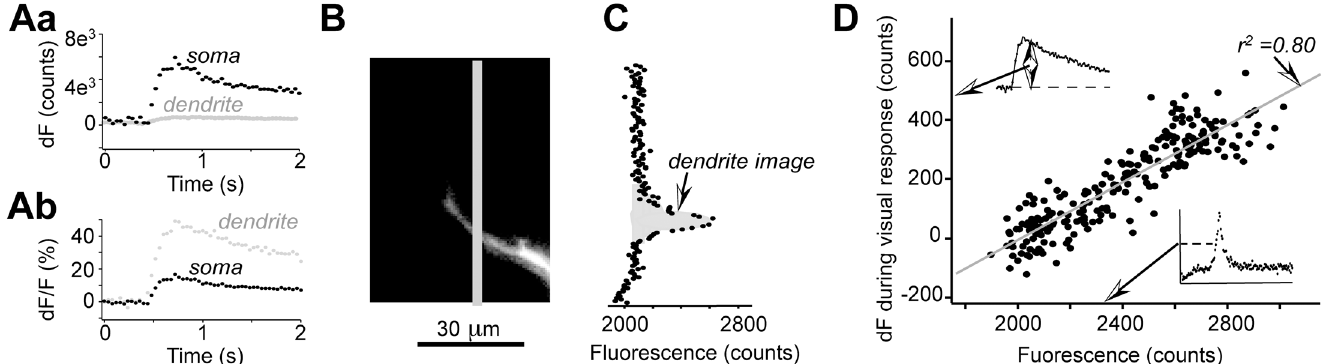
Fig 2. The recorded calcium transients could be detected only on the dendritic branches of the patch-clamped neuron. A . Calcium indicator OGB-1 fluorescence signals in response to several action potentials are shown for soma (black dots) a proximal dendritic branch (grey dots). In Aa absolute values of intensity are shown while in Ab fluorescence intensity values were normalized to the soma the dendritic branch image intensity values. B . A section of the proximal dendritic branch is shown as an image its fluorescence intensity profile along grey line is shown in C . In D for each pixel the image fluorescence intensity value before stimulus is plotted against a change in the fluorescence intensity during stimulation. A grey line represents a linear fit of all data